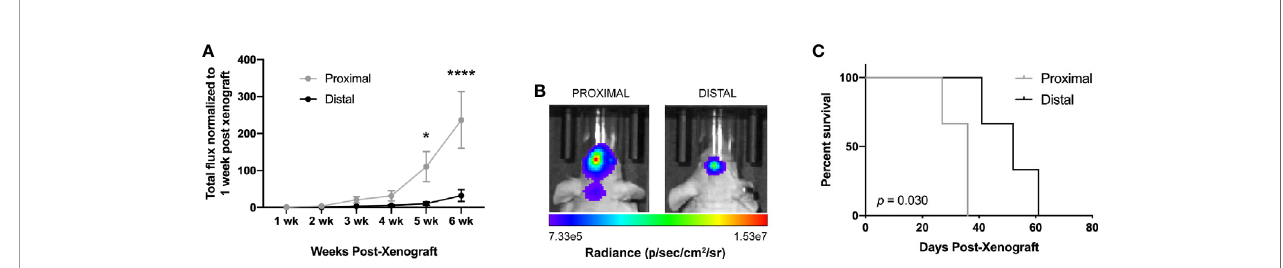
FIGURE 2 | GBM proximity to the lateral ventricles impacts long-term outcome in rodents. (A) Quanti fi cation of BLI total fl ux fold change over time in the LV- proximal and LV-distal GBM tumor conditions (n = 7). (B) Representative BLI images in radiance (photons/second/centimeter/steradian) of immunosuppressed athymic nude mice bearing orthotopic patient-derived GBM at LV-proximal (left) and LV-distal (right) locations at fi ve weeks post injection. (C) Kaplan-Meier survival curve of mice bearing tumors in LV-proximal and LV-distal sites (n = 3). The median survival for LV-proximal or LV-distal tumor bearing mice were 36 and 52 days, respectively. The data are presented as mean ± SEM. * p < 0.05, **** p